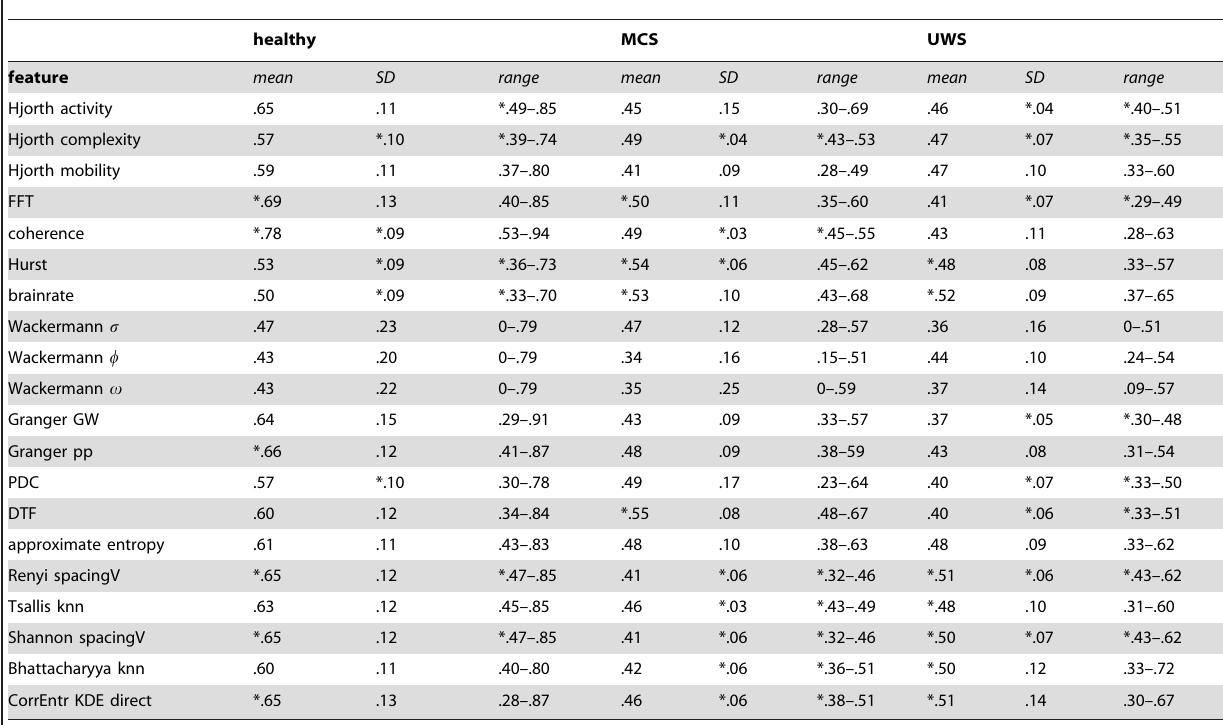
Table 2. Results SVM